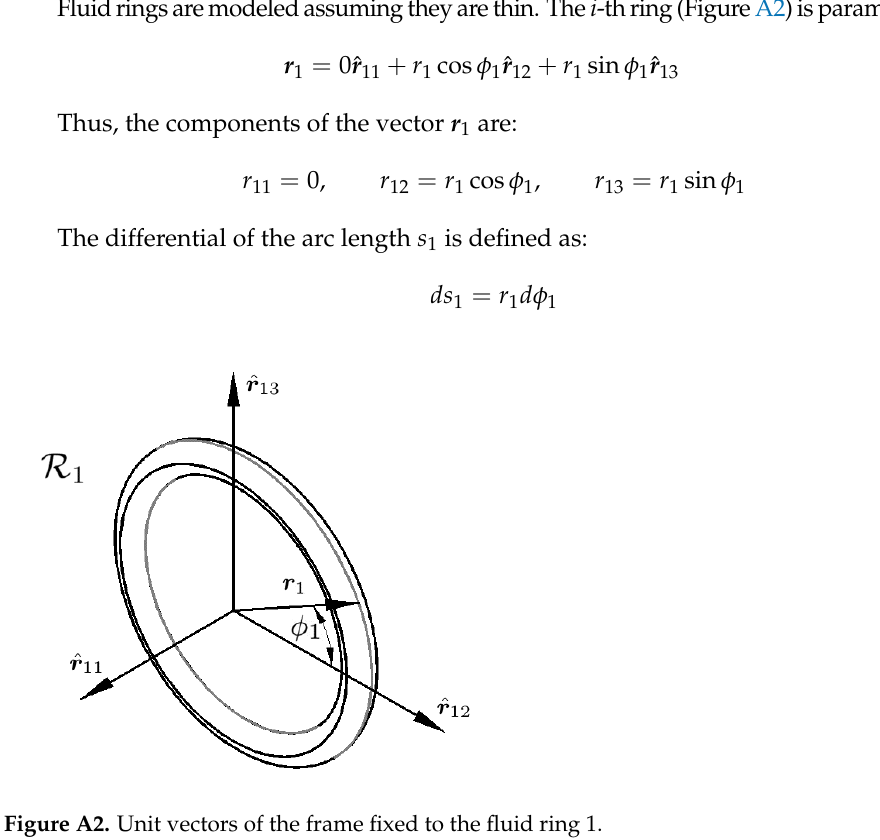
Figure A2. Unit vectors of the frame fixed to the fluid ring